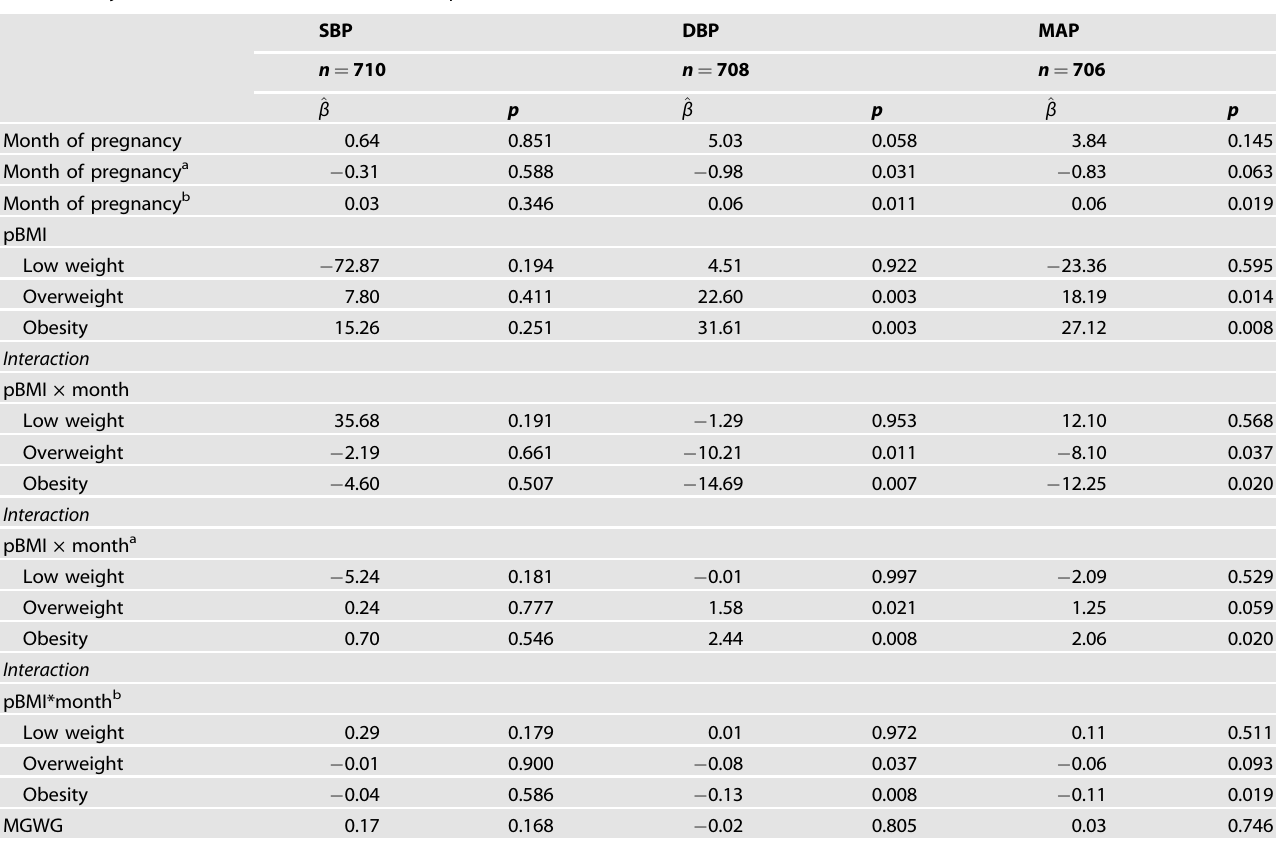
Table 3. Adjusted mixed models results for blood